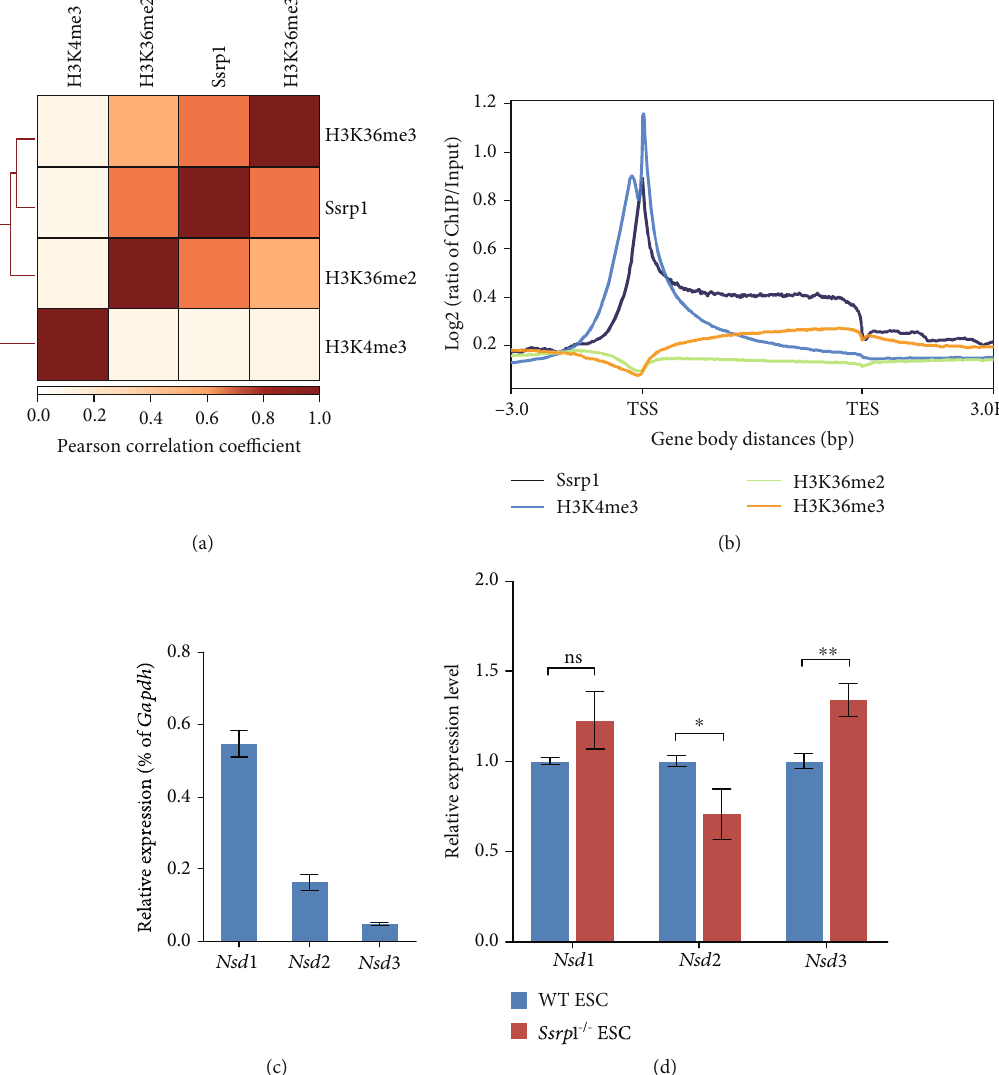
Figure 1: Nsd2-mediated H3K36me2 is correlated with Ssrp1 binding. (a) Genomic distribution pro fi le of H3K36me2, H3K36me3, H3K4me3, and Ssrp1. Color scale represents the strength of Pearson ’ s correlation. (b) ChIP-seq signal density enrichment of Ssrp1, H3K4me3, H3K36me2, and H3K36me3 ( Y -axis) on gene body from TSS to TES ( X -axis). H3K36me3 enrichment increased from TSS to TES. (c) Relative mRNA expression of Nsd1 , Nsd2 , and Nsd3 in ESCs according to qPCR. (d) qPCR analysis of Nsd1 , Nsd2 , and Nsd3 expression levels in WT ESC and Ssrp1 -/- ESC; data are shown as mean ± s : e : m : ; n = 3 biologically independent repeats. ns: nonsigni fi cant; ∗ p < 0 : 05 ; ∗∗ p < 0 : 01